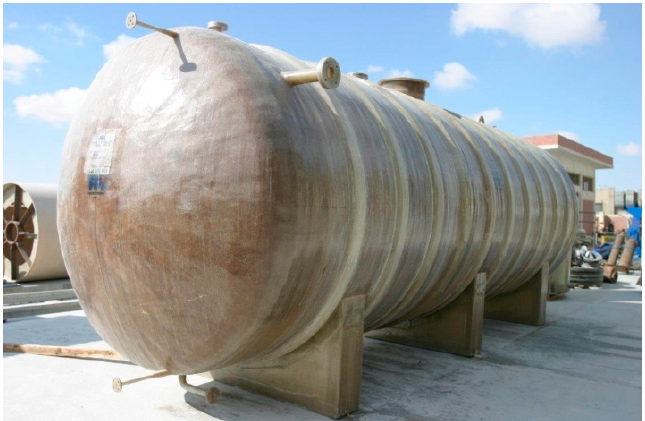
Figure 14. Pressure vessel made of thermosetting resin and fiberglass reinforcement, reproduced from [204] under open access license.